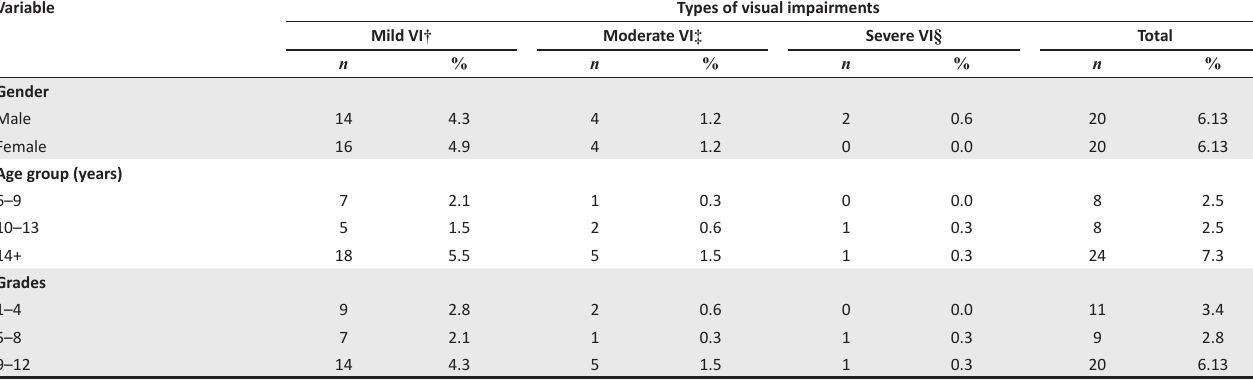
TABLE 5: Prevalence of visual impairment according to gender, age and grade. Variable